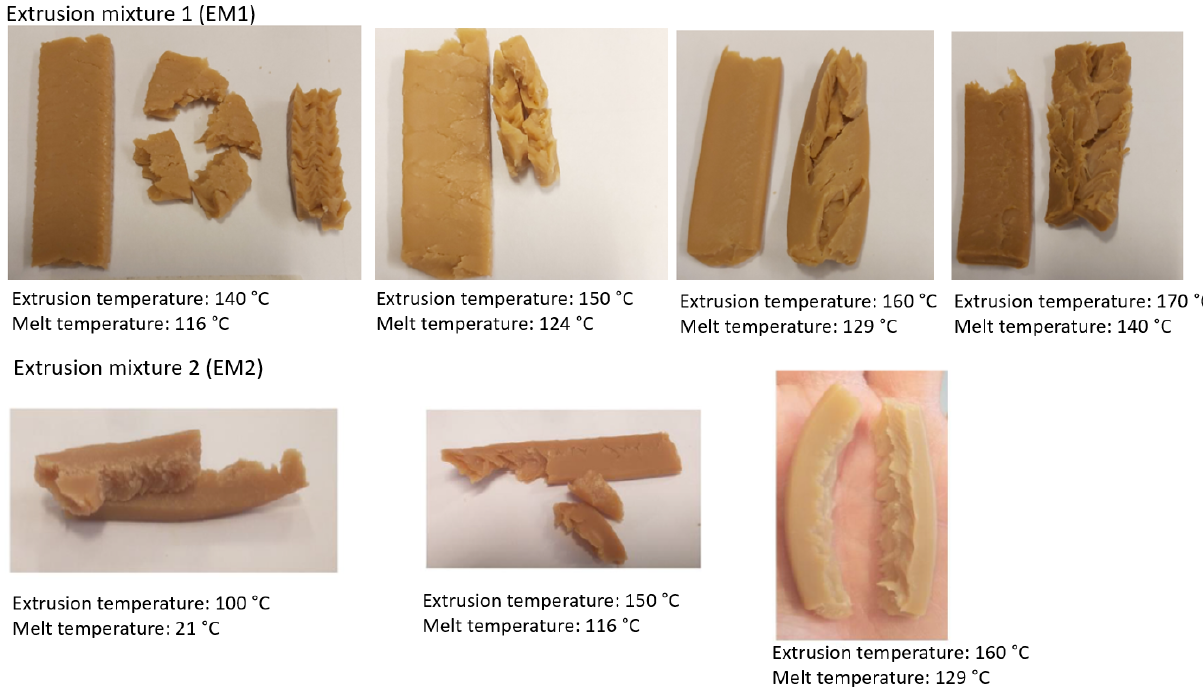
Figure 4. Formation of the fibrillar structure of extruded samples (EM1 and EM2).